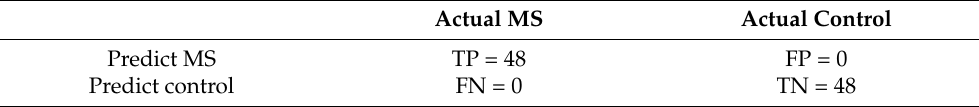
Table 1. Confusion matrix. TN: true negative, FP: false positive, FN: false negative, TP: true